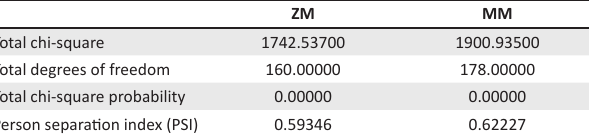
TABLE 5: Test fit to the model.